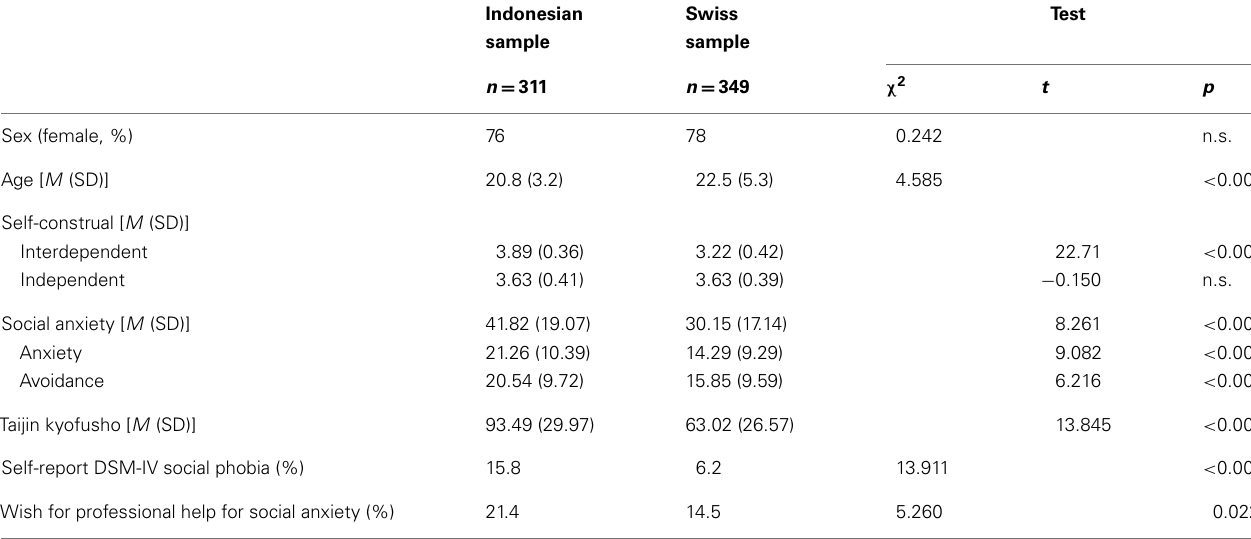
Indonesian Swiss sample